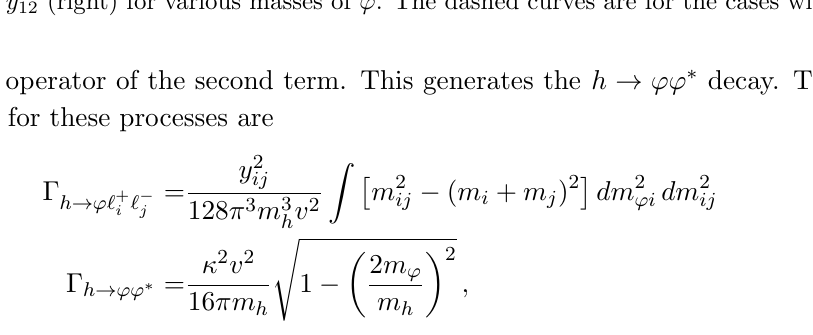
Figure 2 . The branching ratio of Left: h ! ’’ (cid:3) and Right: h ! ’ e (cid:0) (cid:22) + processes as a function of (cid:20) (left) and y 12 (right) for various masses of ’ . The dashed curves are for the cases with real ’